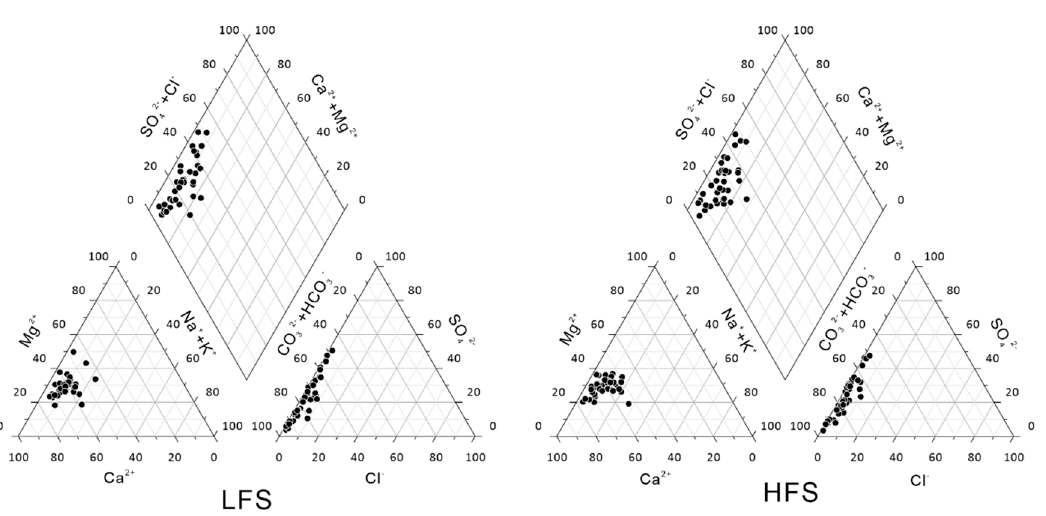
Figure 4. Piper diagram for the water samples from the upper reaches of Syr Darya River and its tributaries.